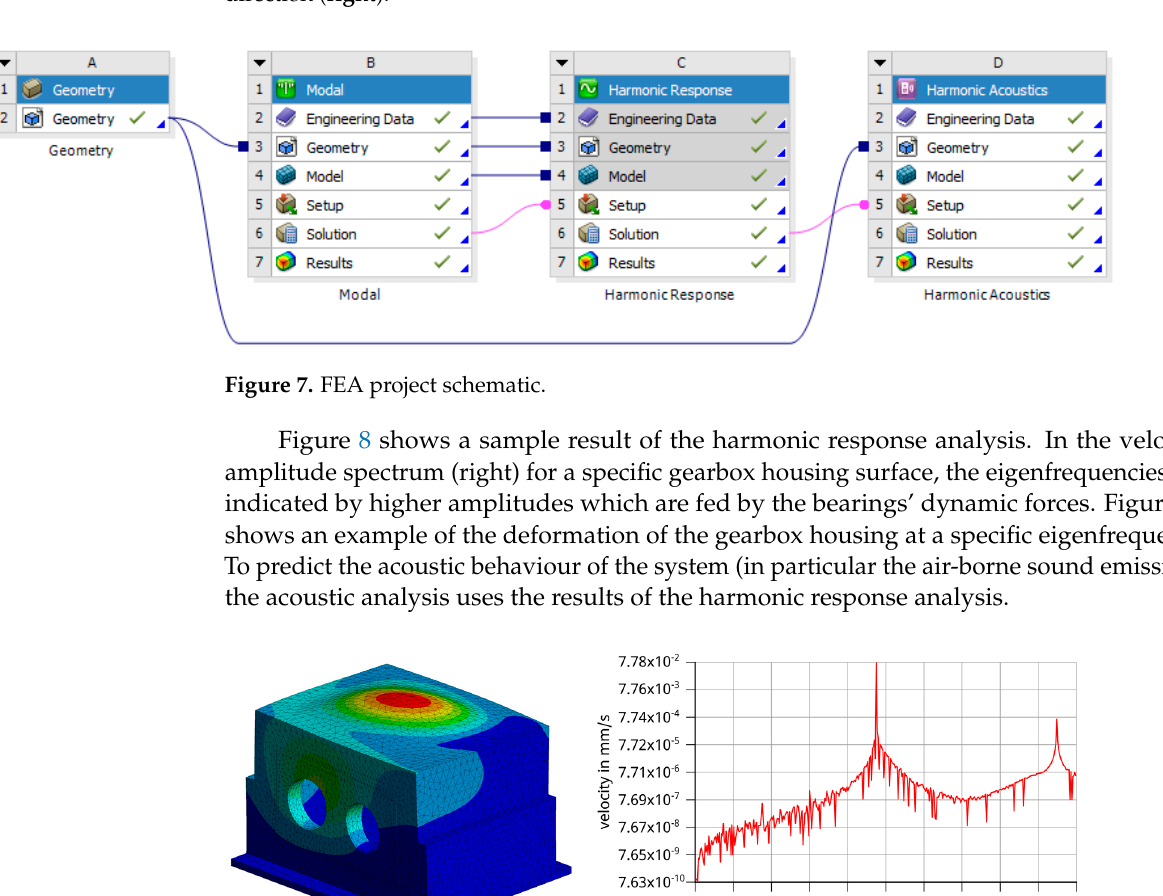
Figure 6. Translational systems for calculating bearing forces in z- and y-direction ( left ), and x-direction ( right ).